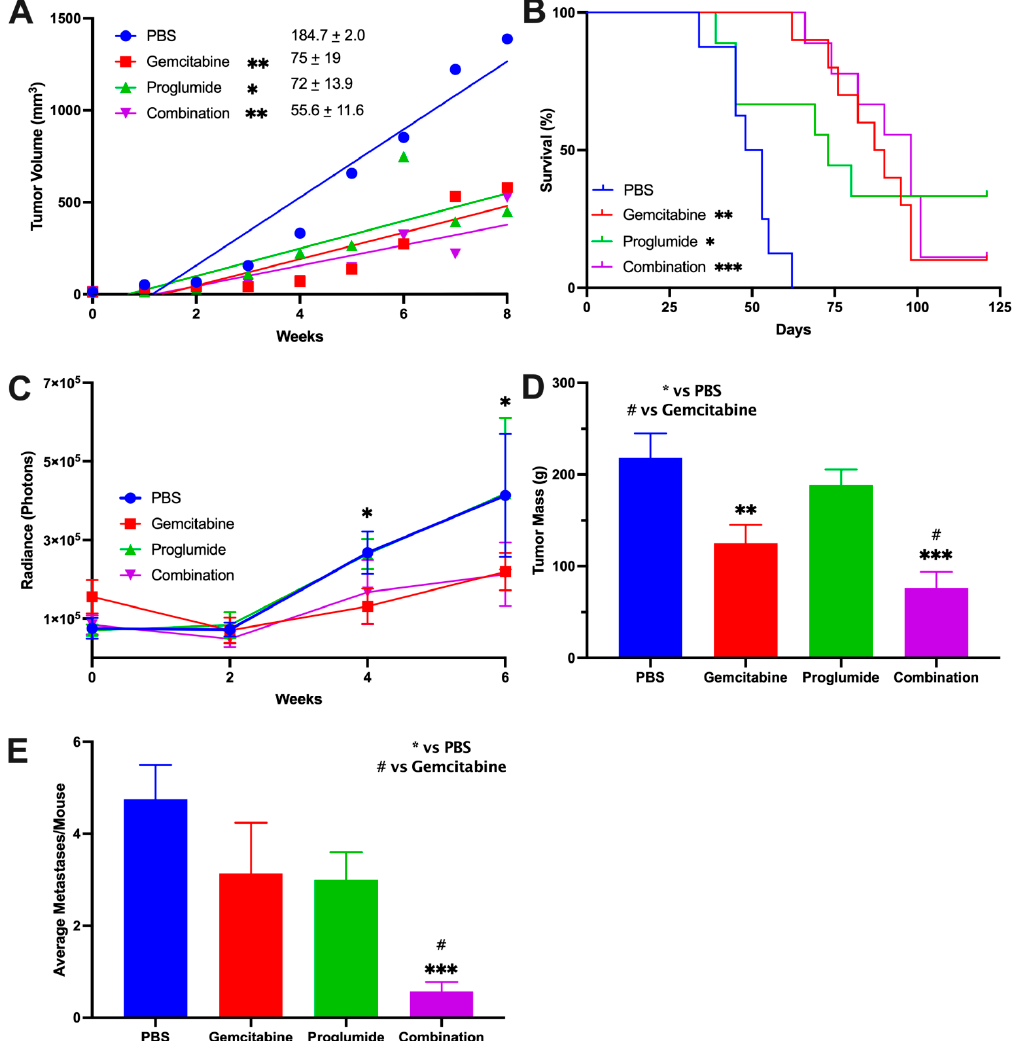
Figure 1. Combination therapy with gemcitabine and a CCK receptor antagonist significantly slows pancreatic tumor growth, prolongs survival, and decreases metastases. ( A ) Tumor volumes for the first eight weeks while all mice were alive are shown for the mT3-2D tumors in C57BL/6 immunocompetent mice. The slope of the growth curve for PBS-treated control mice was the greatest (184.7 ± 2.0). Gemcitabine (slope = 75 ± 19) and proglumide (slope = 72 ± 13.9) growth rates were comparable. The mice treated with a combination of gemcitabine and proglumide had the slowest growth rate (slope = 55.6 ± 11.6). Statistically significant compared to control (* p < 0.05, ** p < 0.005). ( B ) Kaplan–Meier survival curve of mice in all treatment groups. By day 62, all of the PBS-treated (control) mice died. The median survival was significantly increased for combination therapy, followed by gemcitabine, proglumide, and then the PBS-control group. Log-rank was significant compared to controls (* p = 0.01, ** p = 0.005, *** p < 0.0005). ( C ) Primary tumor size of human PANC-1 orthotopic tumors were measured by luciferase flux and show equal flux at baseline (week 0) when treatment was initiated. Over time, the luciferase flux of the tumors was less in the mice receiving combination therapy with gemcitabine and proglumide compared to PBS controls. By week 6, the tumors of mice receiving gemcitabine monotherapy also exhibited less flux compared to controls (* p < 0.05). ( D ) Final PANC-1 tumor mass at the end of the experiment shows significantly smaller tumors in gemcitabine treated mice (* p = 0.042) and tumors in the mice receiving combination therapy had even smaller primary tumors (** p = 0.0017, *** p < 0.0005, # p < 0.05). ( E ) Metastases are decreased by the combination of gemcitabine and proglumide. Columns represent the means ± SEM of the number of metastatic lesions identified and confirmed by histology per mouse in each group. Combination therapy significantly reduce the total number and mean number of metastases per mouse (*** p < 0.0005, # p <